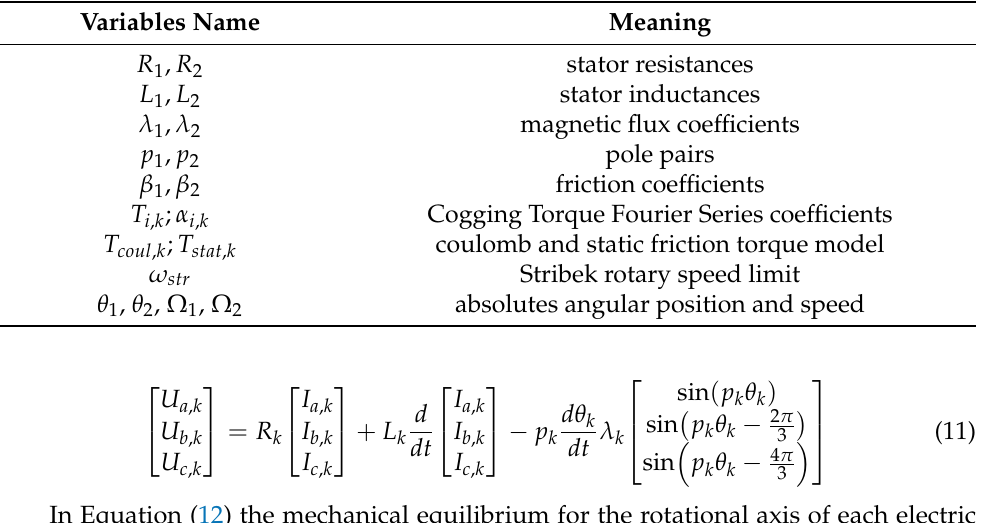
Table 2. Parameters of the Dynamic Actuators